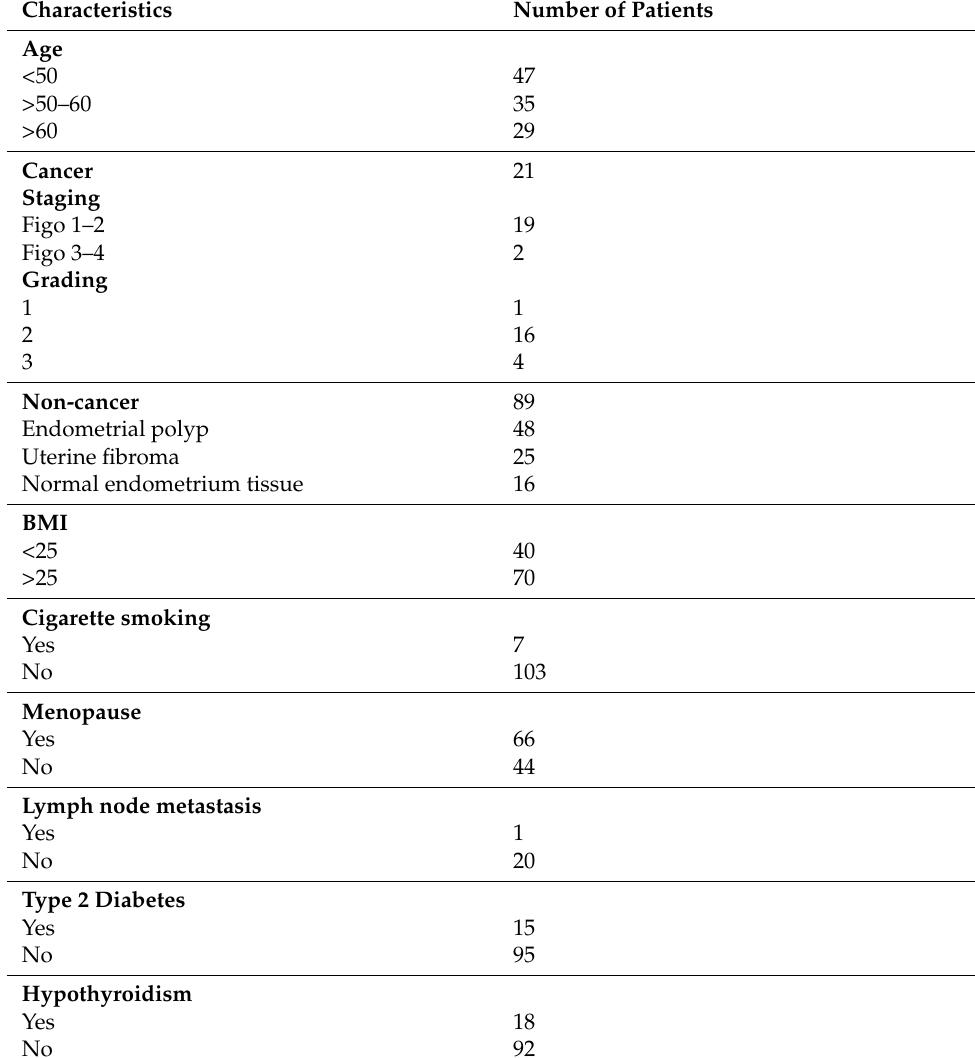
Table 1. Patient